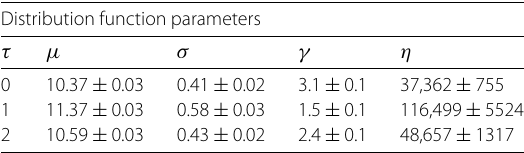
Table 4 Parameters of Eqs. (9) and (10) obtained via maximum likelihood estimation from night population ( τ = 0), daytime population ( τ = 1), and evening population ( τ =